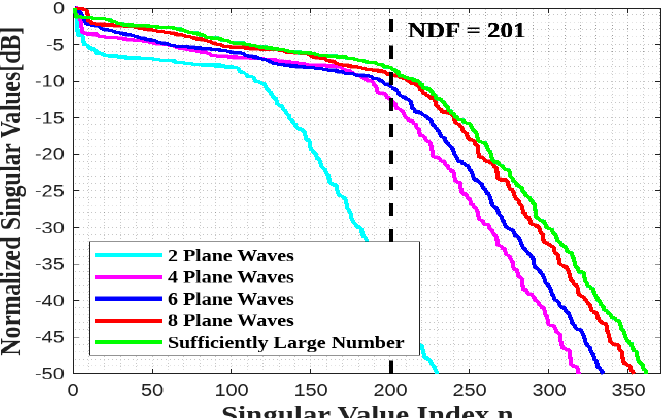
Figure 12. Comparison of the behavior of the normalized singular values for different numbers of impinging plane waves for a single XY face ID.